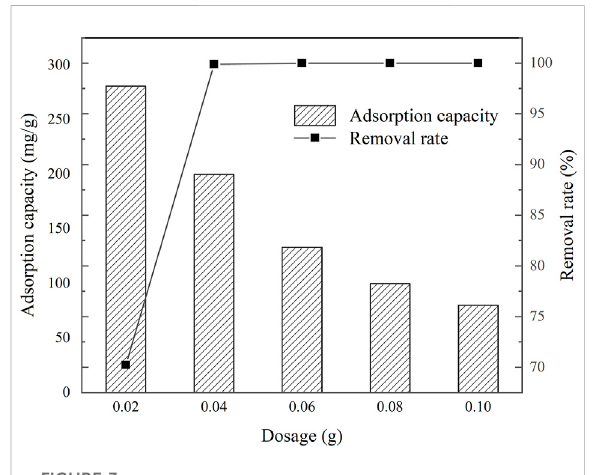
FIGURE 3 Effect of IKBCH dosing on TC adsorption and removal